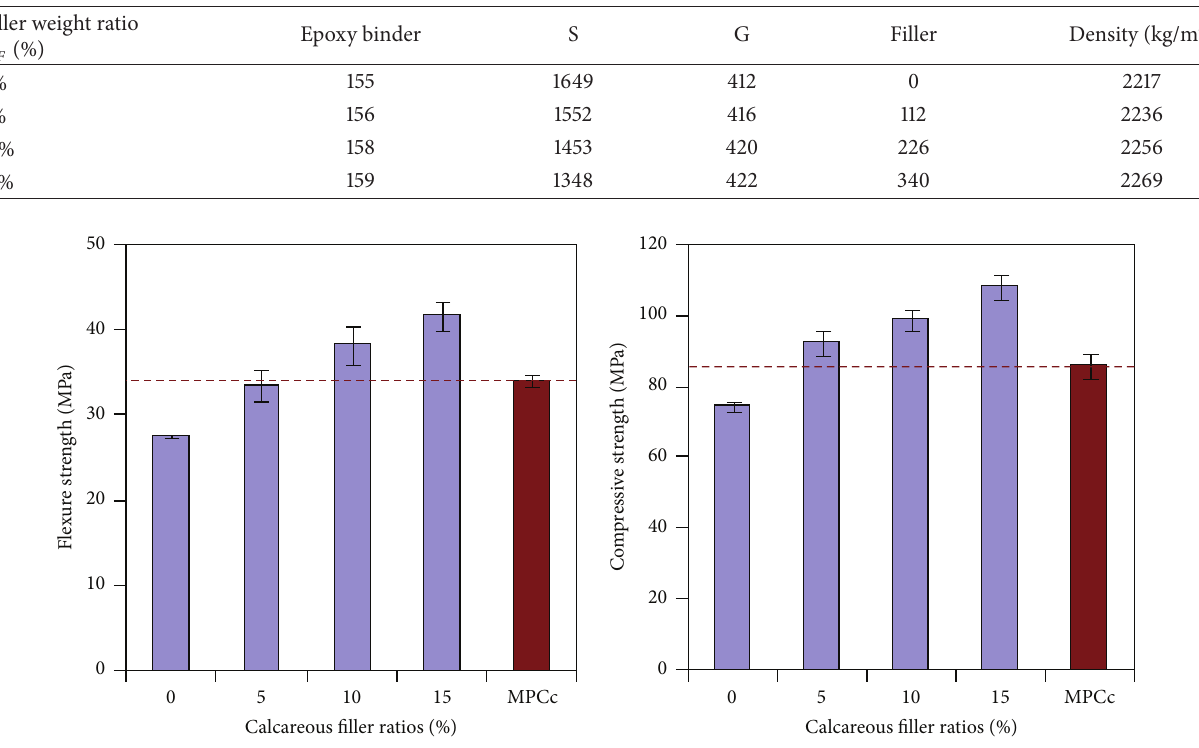
Figure 5: Effect of introducing fillers on the mechanical strengths of MPC.